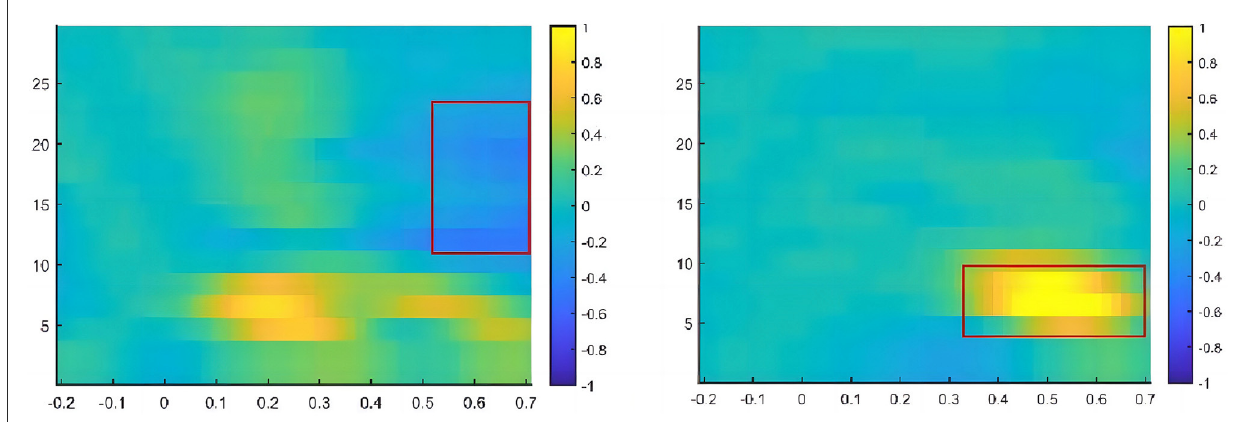
FIGURE3 Schematic diagram of EEG components. EEG components, electroencephalographic components.